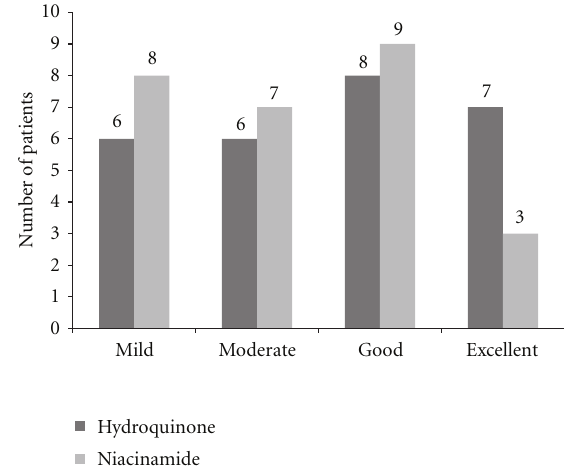
Figure 3: Physicians Global Assessment in melasma patients with niacinamide versus